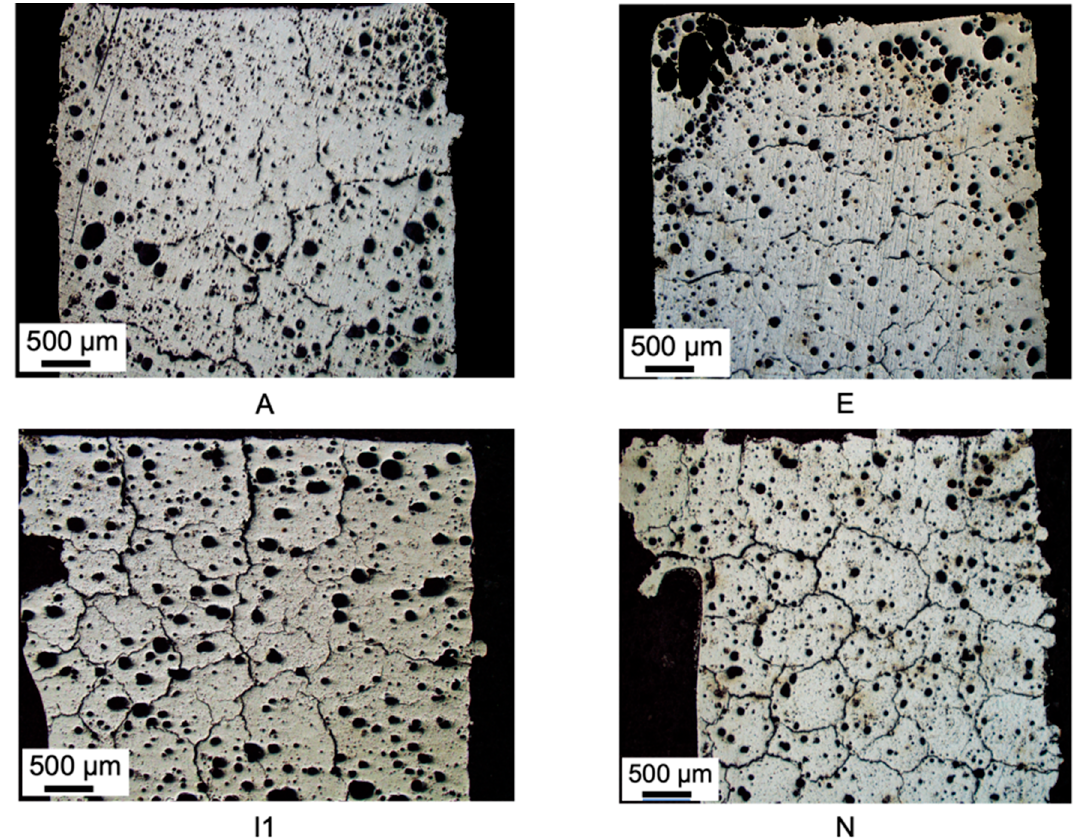
Figure 7. OM micrograph of samples A, E, I1, and N: section perpendicular to the building direc- tion.